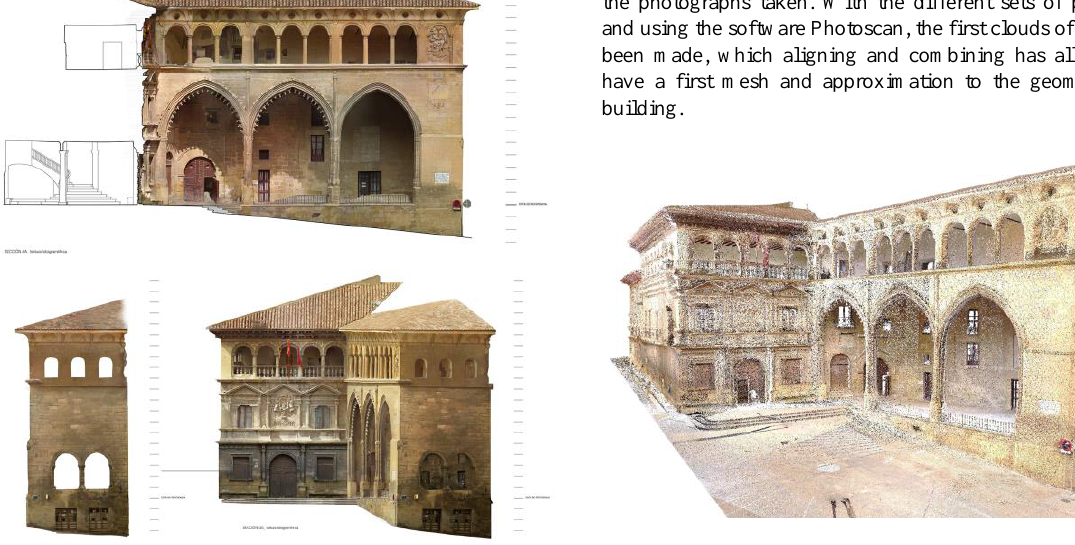
Figure 3. Point cloud obtained by photogrammetry and drone of the Town Hall of Alcañiz